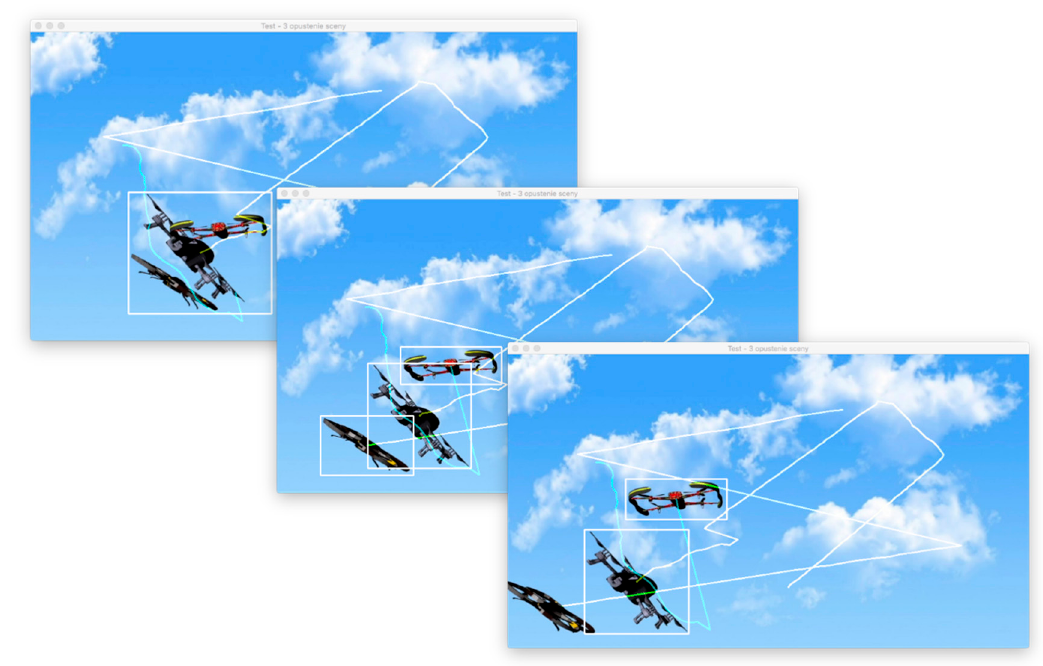
Figure 11. Overlapping of objects.